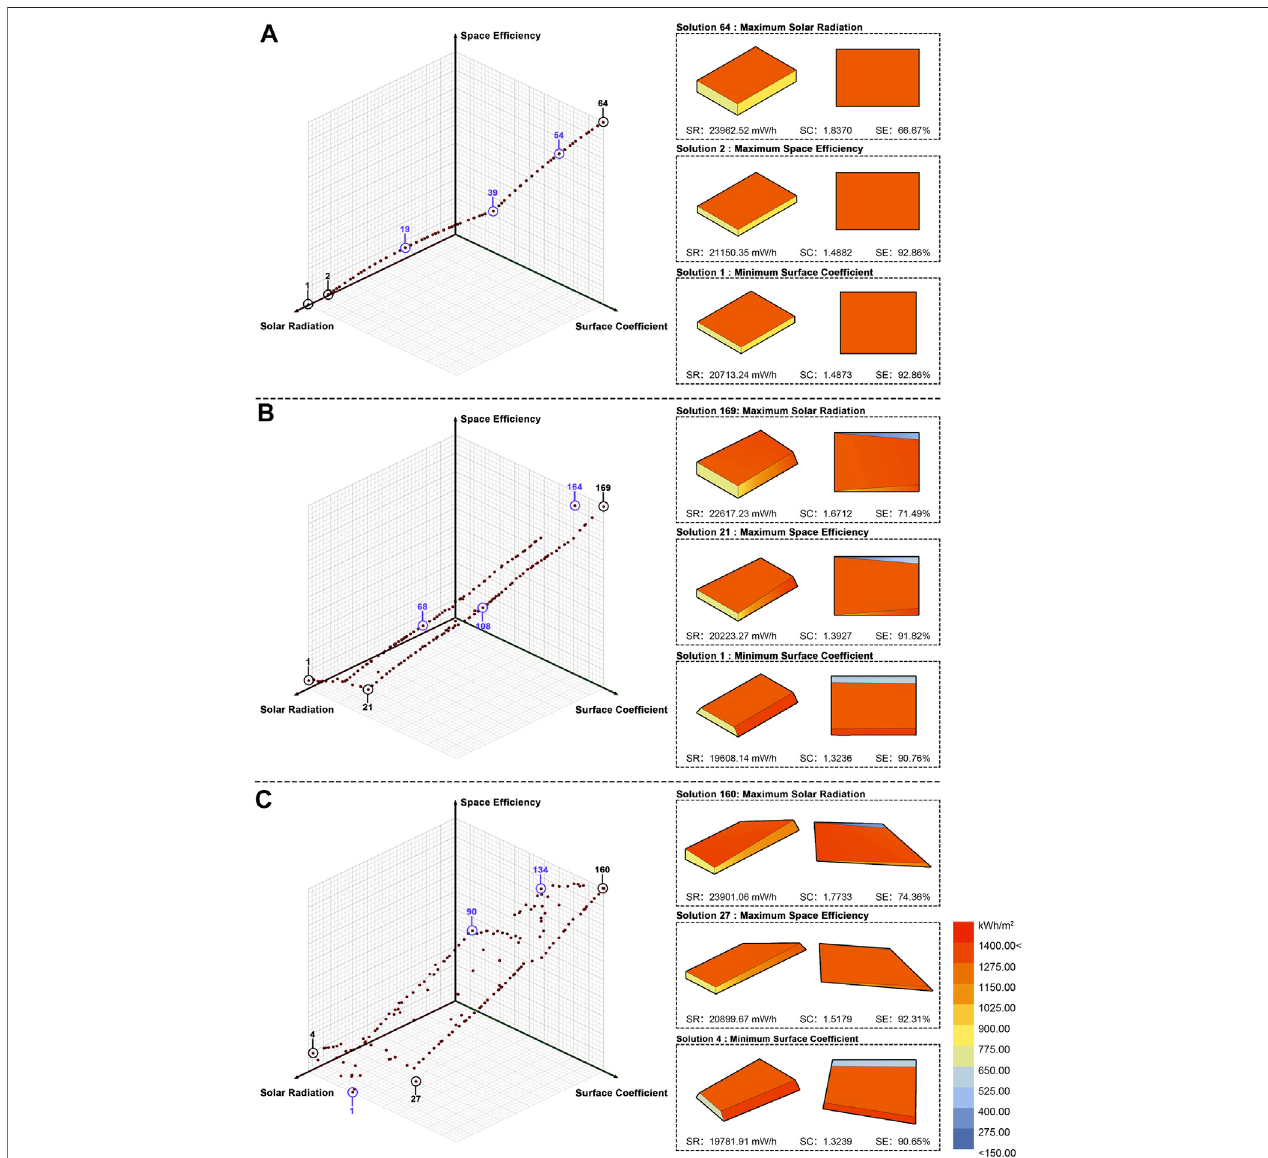
FIGURE 11 | Pareto Frontier of S1 and the building shapes of its optimal solutions: (A) S1; (B) S2; (C) S3.